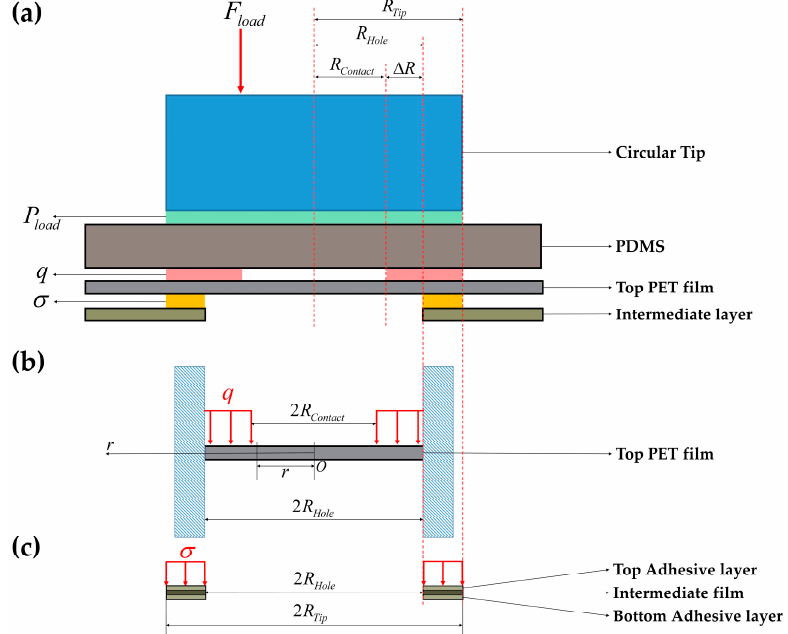
Figure 7. Force diagram for the analytical model of the printable flexible touch sensor. P Load represents the uniformly distributed pressure on PDMS, q represents the uniformly distributed pressure on upper PET film and σ represents the uniformly distributed pressure on intermediate layer; ( a ) Simplified model for the upper half of the sensor; ( b ) Simplified model for deflection of the top PET film; ( c ) Simplified model for deformation of the top adhesive layer, where the double-sided adhesive film consists of the top adhesive layer, the intermediate film and the bottom adhesive layer.